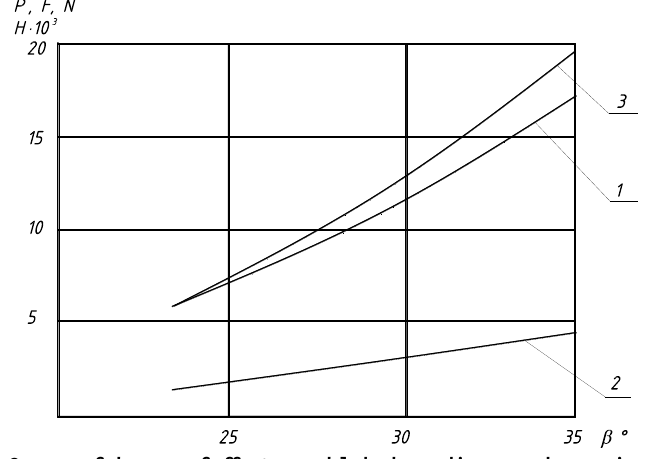
Fig. 2. Curves of changes of efforts on a blade depending on a sharpening